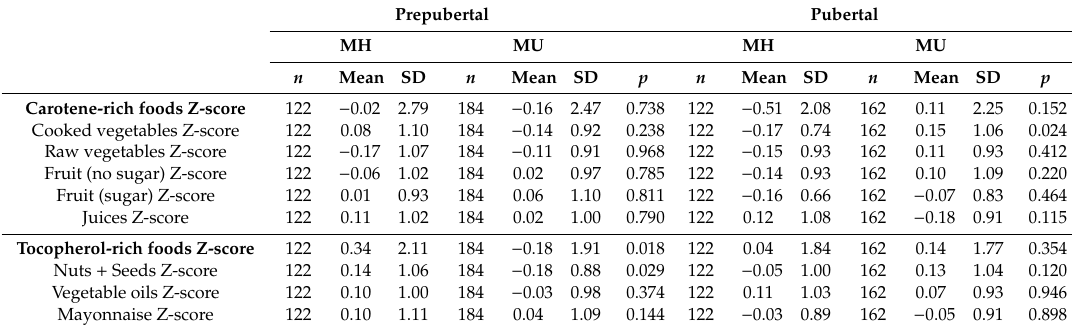
Table 2. Standardized consumption frequency of carotene-rich and tocopherol-rich foods in metabolically unhealthy and healthy children, by pubertal